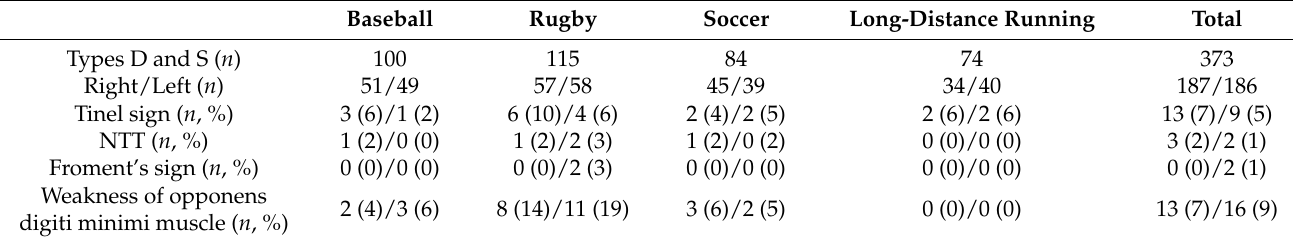
Table 5. Frequency of objective findings among elbows with Types D and S. Baseball Rugby Soccer Long-Distance Running